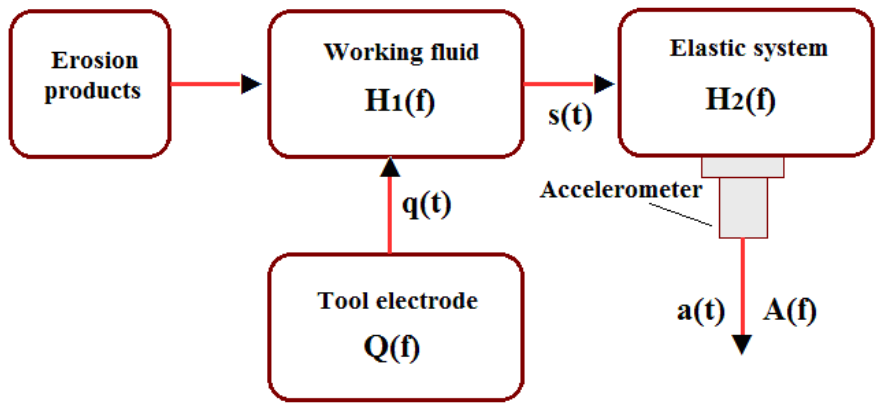
Figure 4. The dynamic model of the WEDM process: Q(f)—spectrum of the discharge current signal q(t); H 1 (f) — AFC of the working fluid; s(t) — working impact on the workpiece, destroying its material; H 2 (f) — AFC of the elastic system together with the workpiece; a(t) — vibration signal at the output of the accelerometer with the spectrum A(f); f — frequency; t — time.